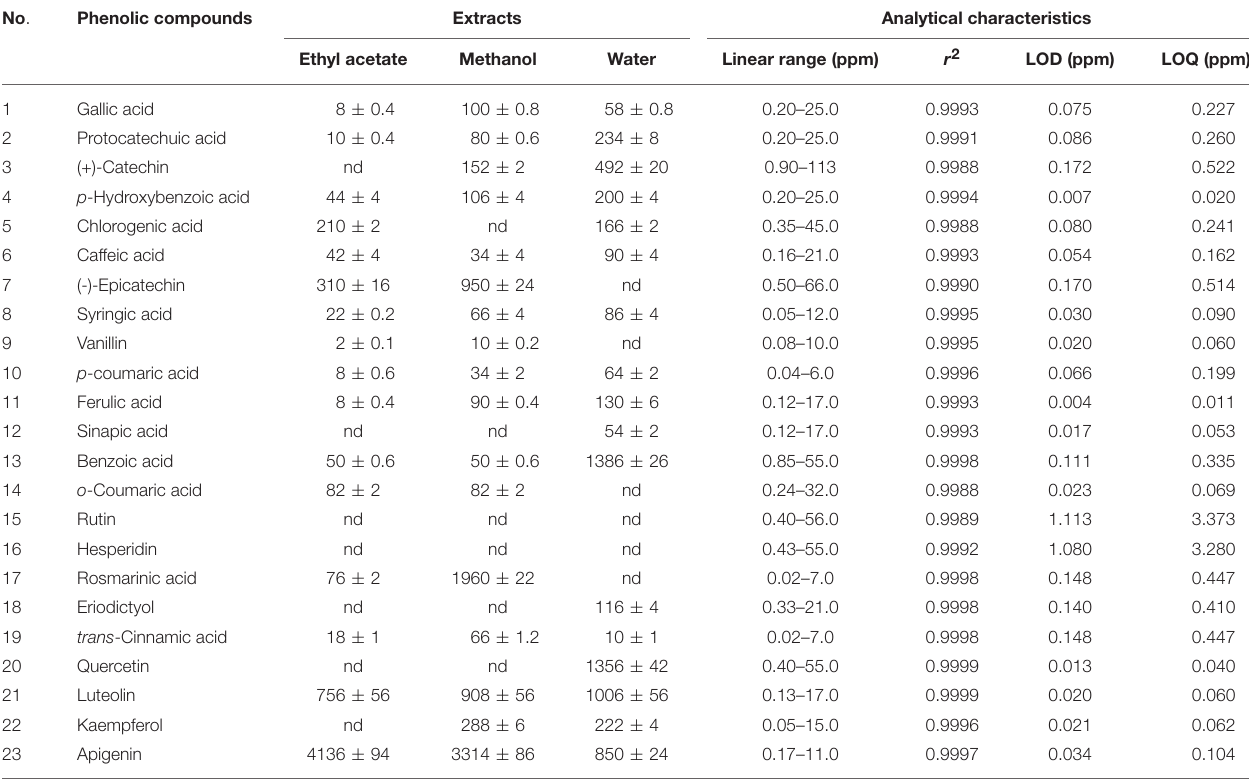
TABLE 4 | Quantitative analysis for determination of phenolic components in the extracts ( µ g/g extract). No